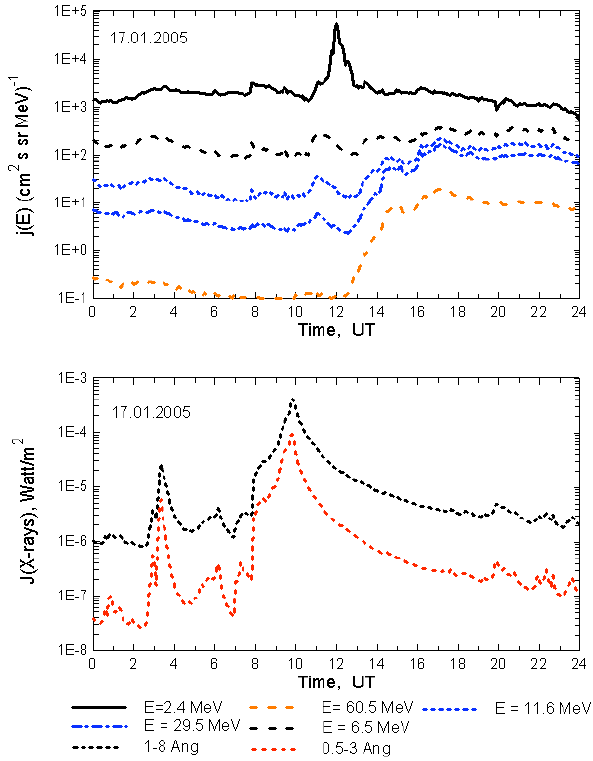
Fig. 2 . Differential solar proton fluxes and hard solar X-rays inten- sity observed on 17 January